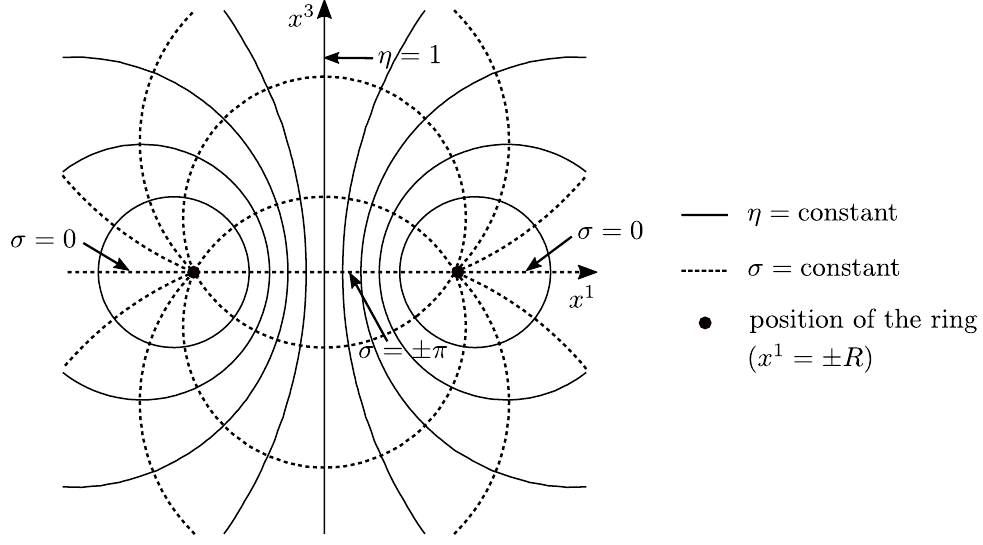
Figure 5 . Toroidal coordinates in the x 2 = 0 section. Solid lines represent constant- (cid:17) surfaces and dotted lines represent constant- (cid:27) surfaces. As (cid:17) ! 1, the constant- (cid:17) surface approaches the vertical ( x 3 ) axis , while the position of the ring corresponds to the (cid:17) ! 1